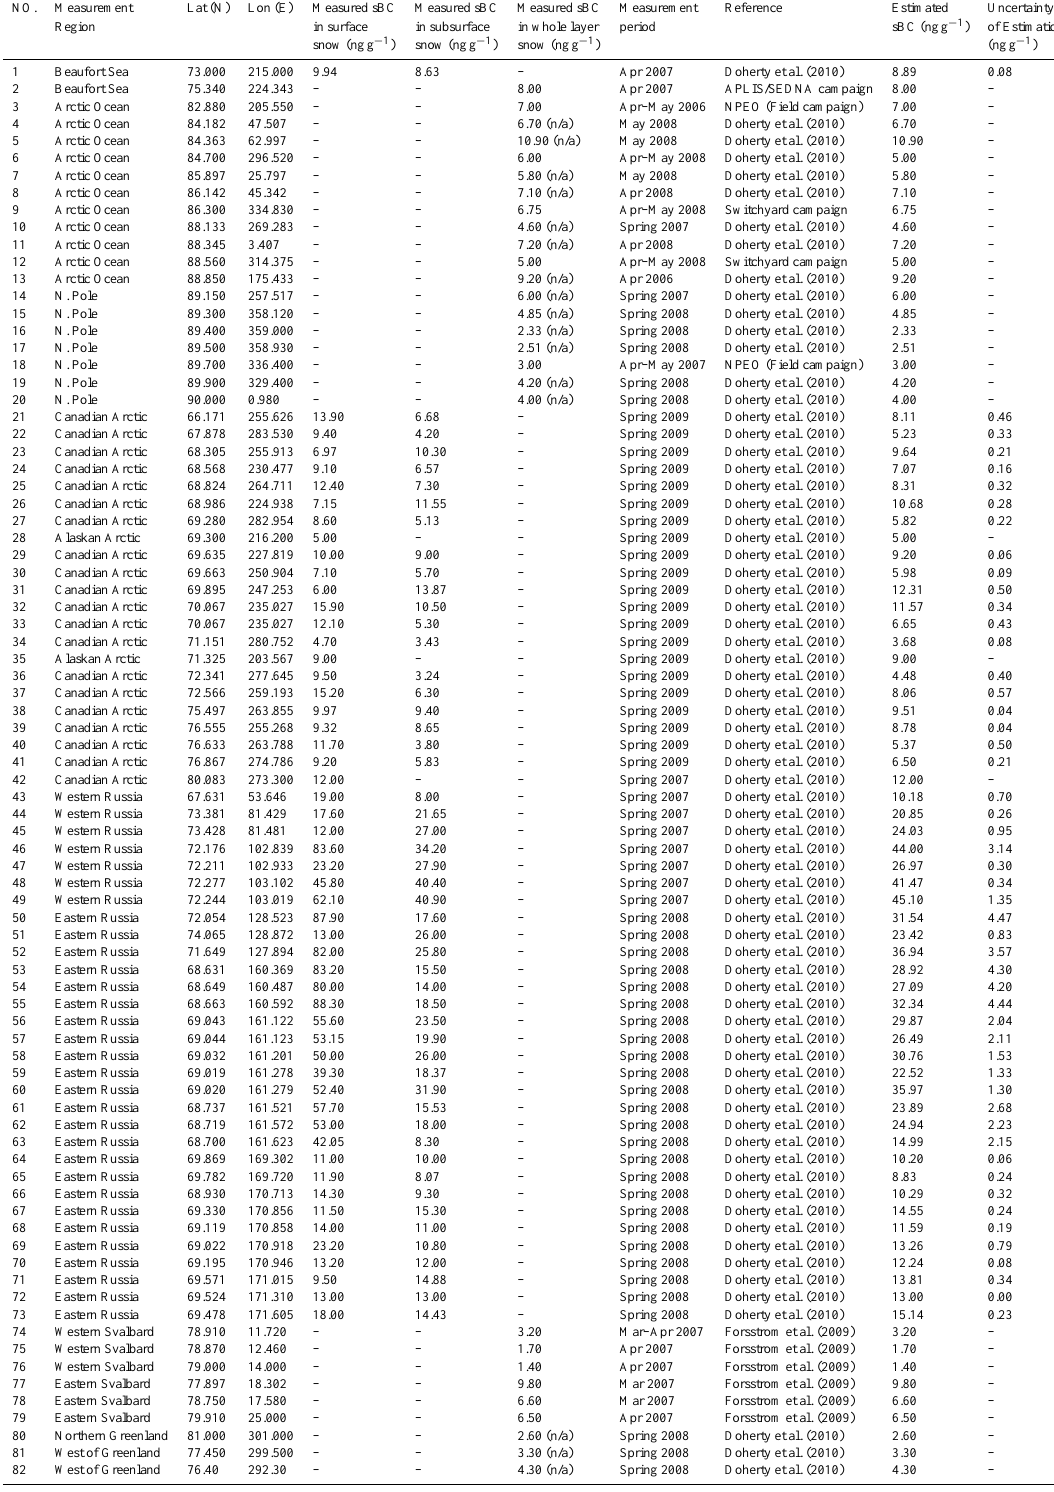
Table 1. Present-day sBC observations in and around the Arctic Ocean in spring. The estimated sBC in this study were calculated from surface and subsurface concentrations with the snow densities obtained in SHEBA field campaign. Most of the surface and subsurface values listed in this table are from Doherty et al. (2010) and others are from several field campaigns known to us. The measurements within a